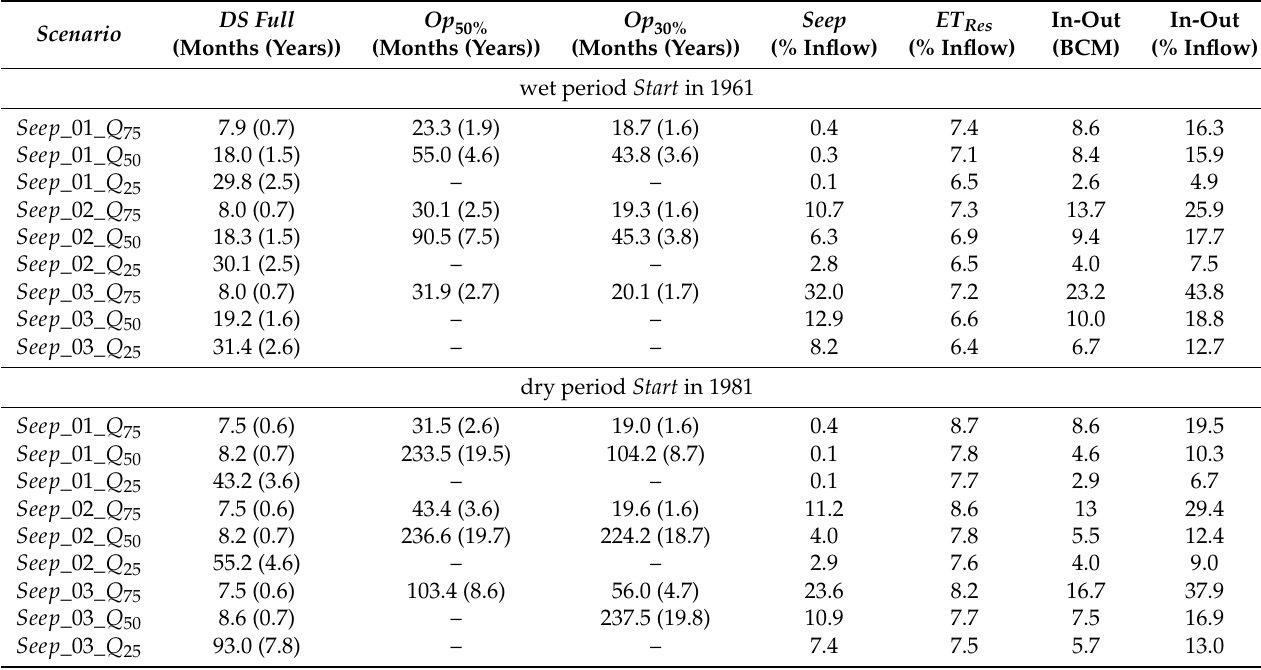
Table 2. Reservoir statistics during filling ( Op = x% of AS filled